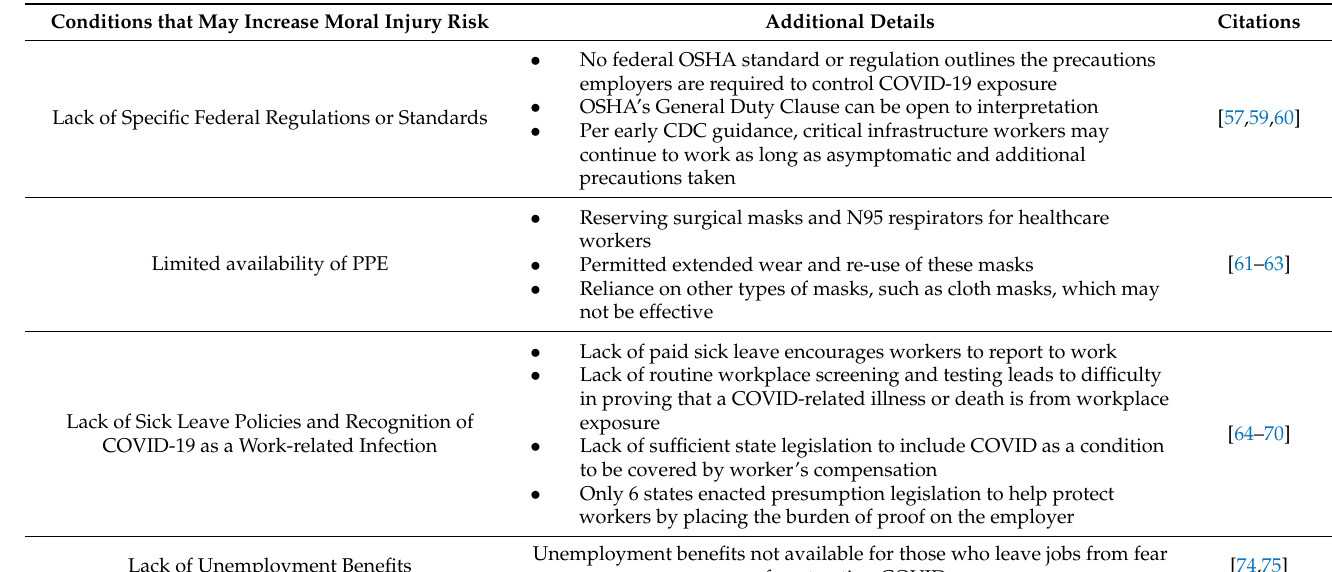
Table 3. Work-related Factors that May Increase Risk of Moral Injury in Essential